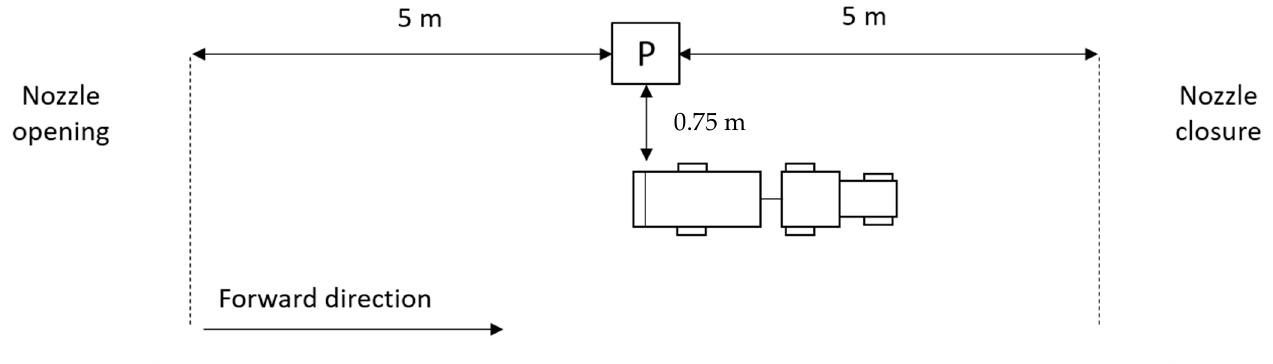
Figure 6. Vertical spray profile distribution evaluation system ( left ). Cylinders where the spray collected by height accumulates ( right ).